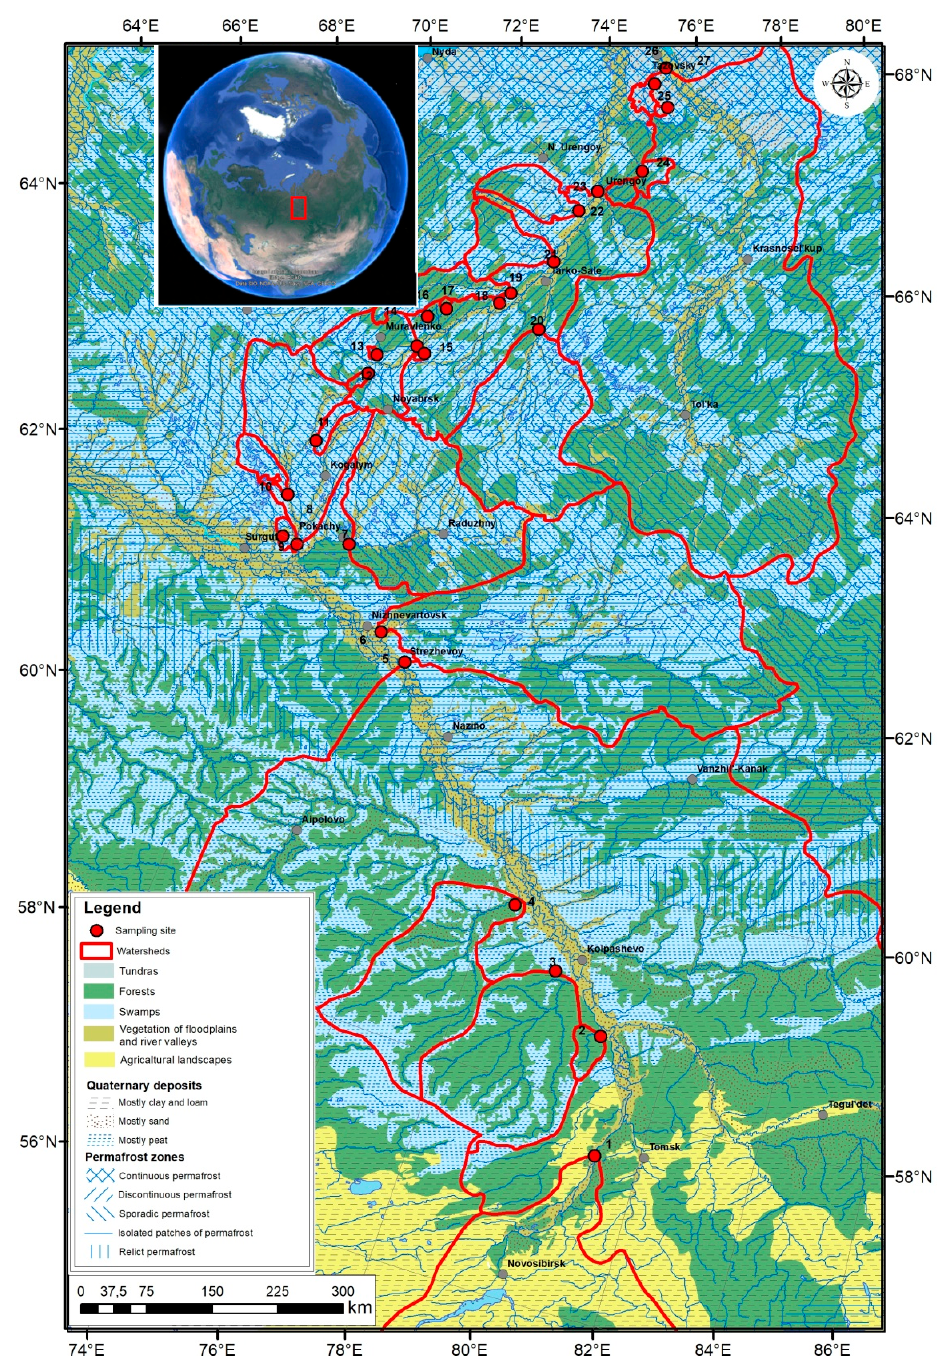
Figure 1. The WSL river sampling points. The numbers on the map correspond to the following rivers: (1) Ob’ (Pobeda), (2) Maliy Tatosh, (3) Chaya, (4) Vyalovka, (5) Ob’ (Aleksandrovskoye), (6) Vakh, (7) Agan, (8) Tromyegan. (9) Vach-Yagun, (10) Vachinguriyagun, (11) Pintyr’yagun, (12) Kamgayakha, (13) Khatytayakha, (14) Pyakupur, (15) Lymbyd’yakha, (16) Apoku-Yakha, (17) Etu-Yakha, (18) Seryareyakha, (19) Purpe, (20) Aivasedapur, (21) Tydylyakha, (22) Yamsovey, (23) Pur, (24) Ngarka Khadyta-Yakha, (25) M. Kheyakha, (26) Nuny-Yakha, (27) Taz. The upper left insert is from Google Maps ® .